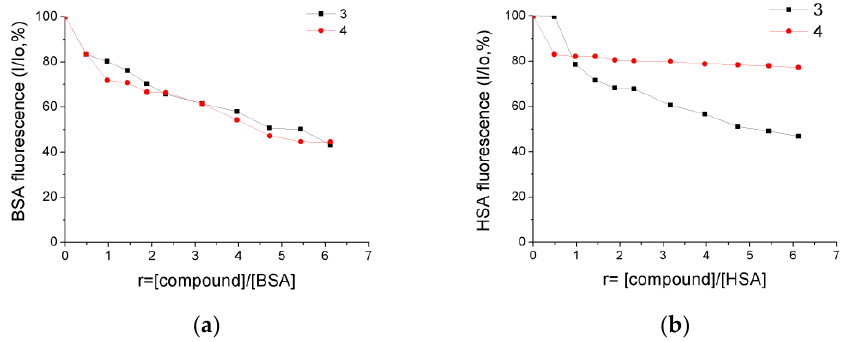
Figure 8. Plots of percentage of fluorescence intensity changes (I/I o , %) at ( a ) λ max (em) = 350 nm for BSA and ( b ) λ max (em) = 338 nm for HSA, in buffer solutions (150 mM NaCl and 15 mM trisodium citrate at pH = 7.0) upon addition of increasing amounts of compounds 3 and 4 versus r = [compound]/[BSA] and r = [compound]/[HSA], respectively. The fluorescence-quenching constants k q for SA, obtained using the Stern–Volmer